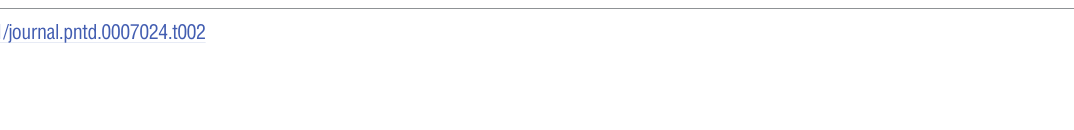
Sensitivity and specificity of the qPCR using clot samples was calculated considering the serology (positive to all ELISA, HAI and Western blot positive) as the gold